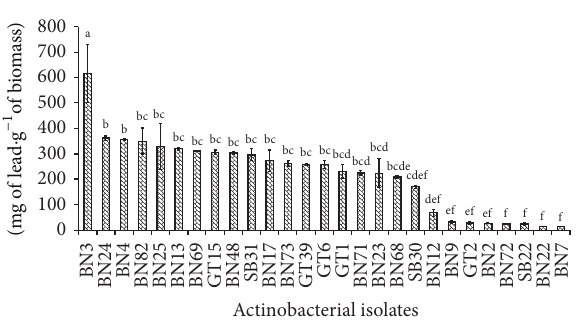
Figure 4: Quantities of removed lead by the tested actinobacteria